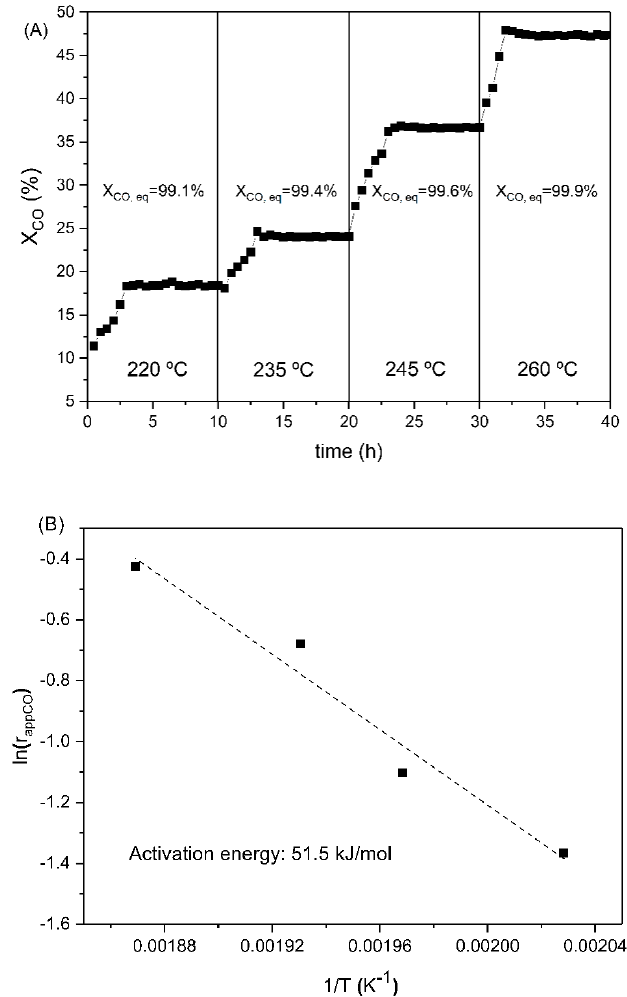
Figure 9. ( A ) Conversion of CO in WGS reaction feeding H 2 over 0.3Pt / CoAl catalyst at 50 bar; ( B ) Arrhenius plot. Reaction conditions: W cat = 0.2 g, F H2O = 0.04 mL / min, F CO = 3.5 mL / min, F H2 = 14 mL / min. Table 5. Apparent reaction rate normalized per Pt site (r app, co) on the H 2 chemisorption basis.